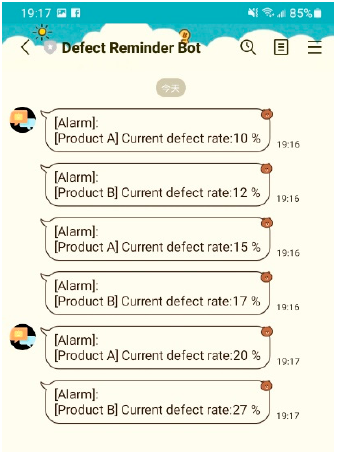
Figure 15. Real-time anomaly notification via Bot.